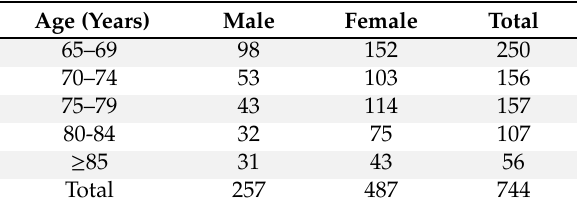
Table 2. Demographics of the study